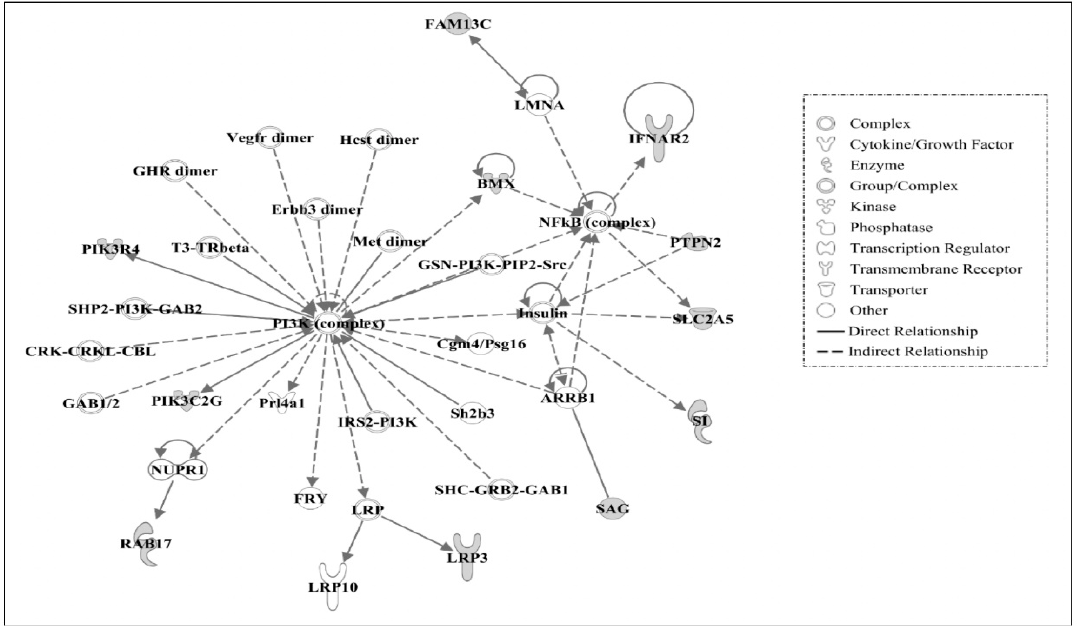
Figure 5. Gene network #3. Molecular interaction and symbols are the same as described in Figure 3.